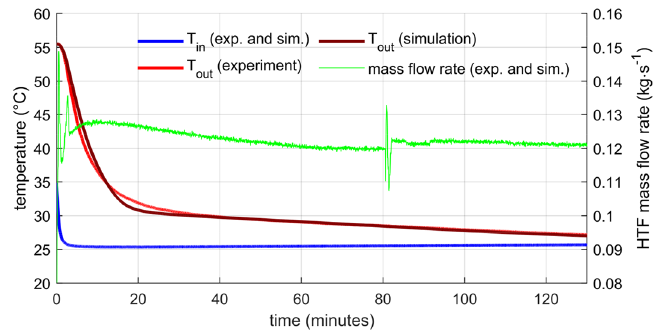
Figure 8. HTF temperature evolution—comparison of the numerical model with the experimental data for lower HTF flow rate. The greatest discrepancy was between 15 and 25 min.